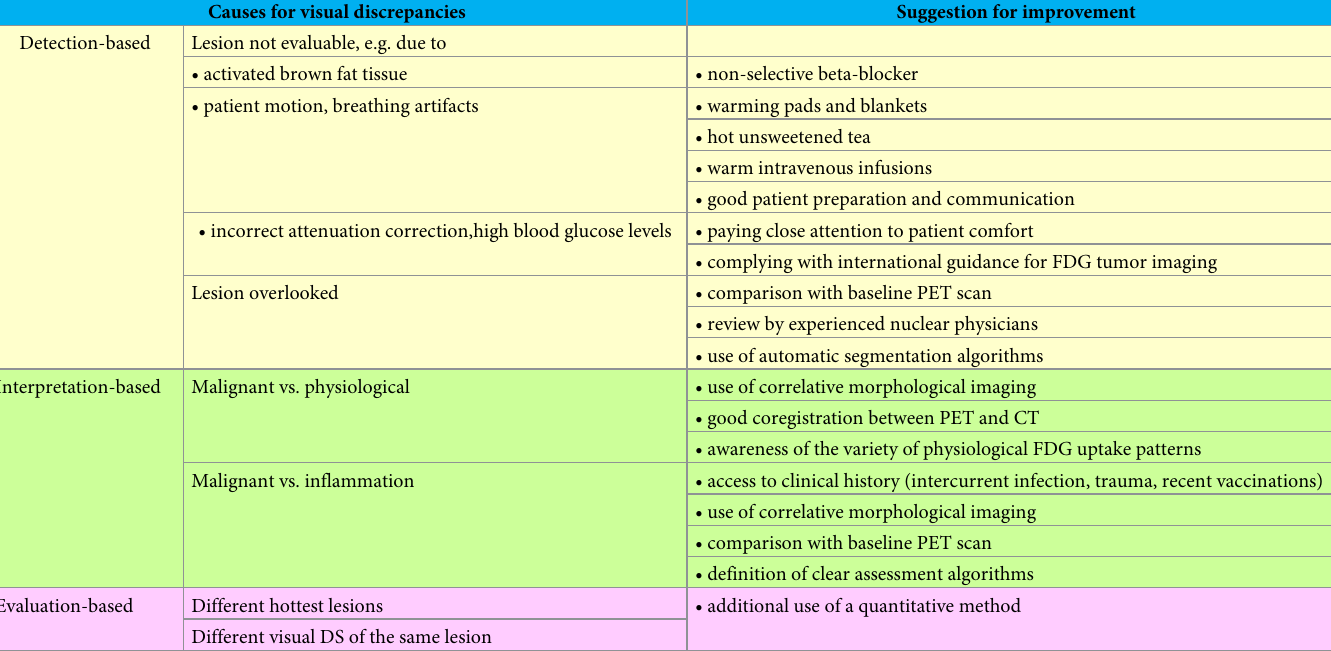
Table 4. Causes for interobserver discrepancies in the visual Deauville scoring and suggestions for improvement. Causes for visual